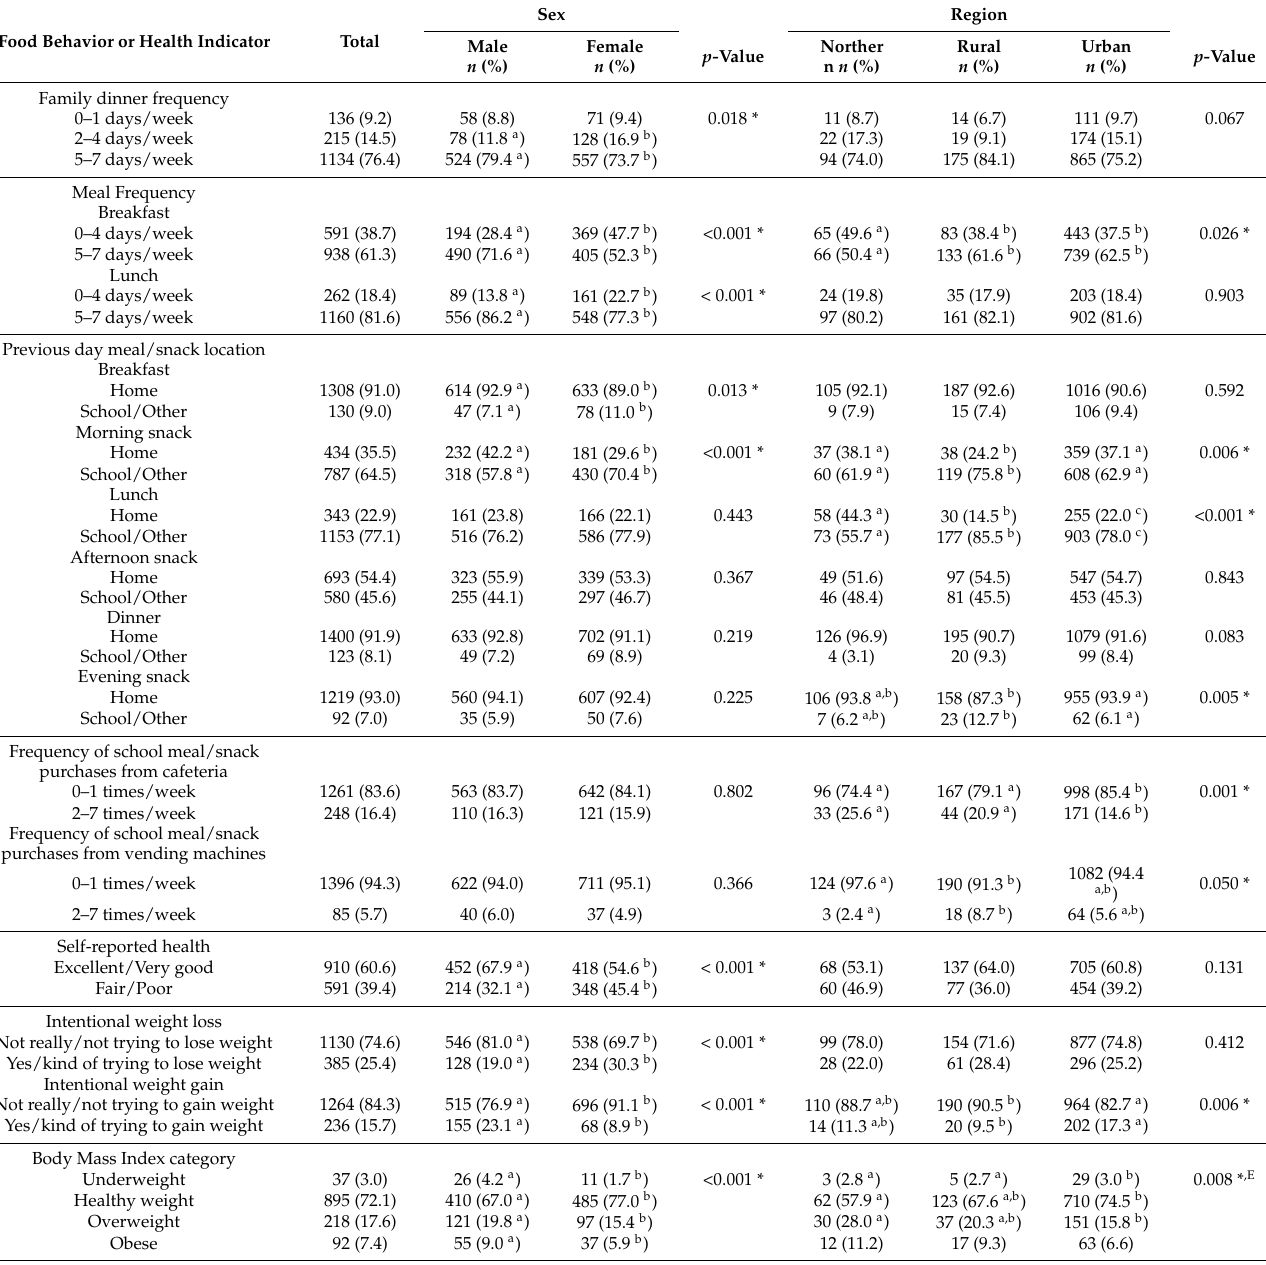
Table 1. Food behaviours and health indicators according to sex and region of